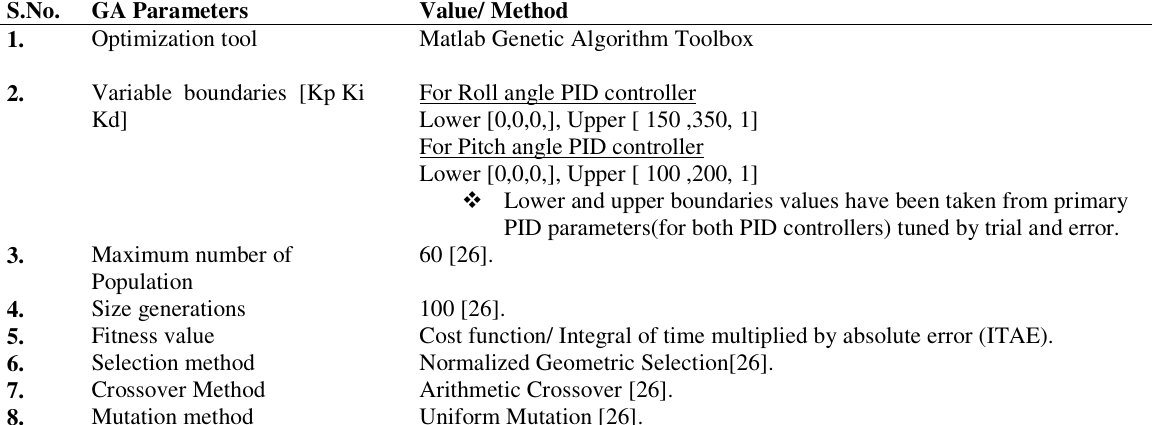
Cost function/ Integral of time multiplied by absolute error (ITAE). Selection method Normalized Geometric Selection[26]. Crossover Method Arithmetic Crossover [26]. Mutation